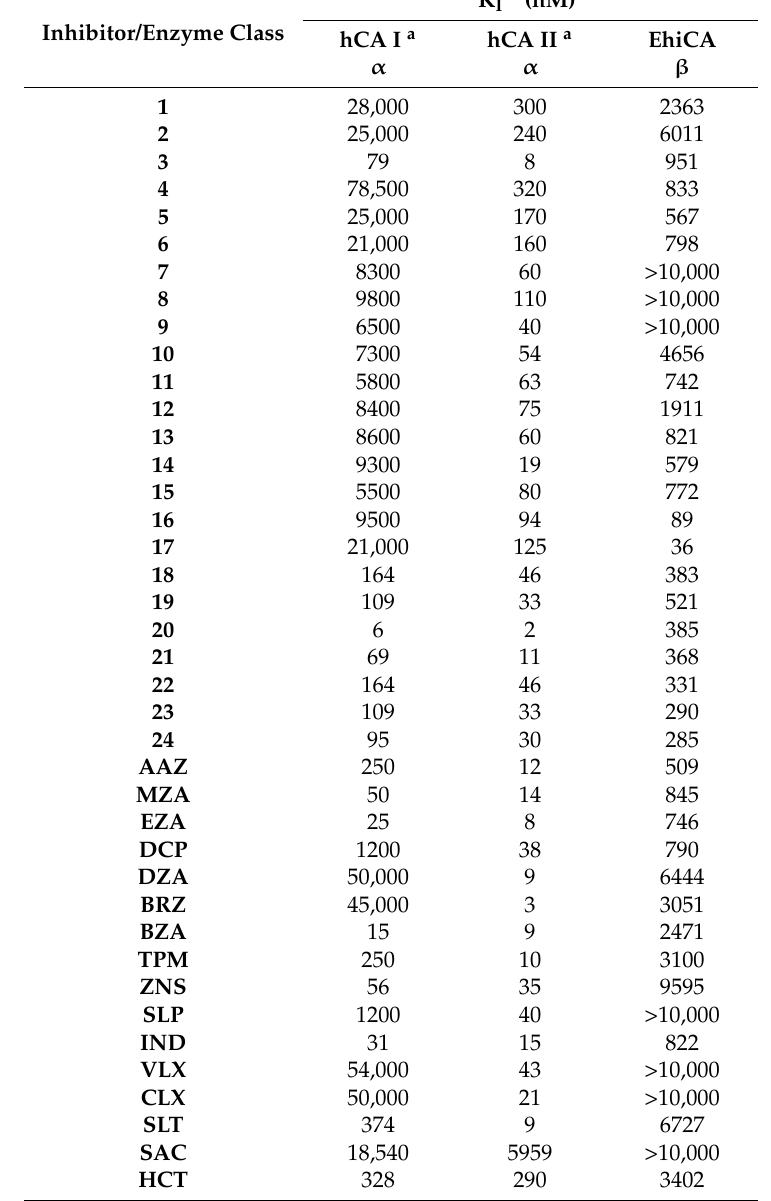
Table 2. Inhibition of the human isoforms hCA I and hCA II, and Entamoeba histolytica (EhiCA) from Entamoeba histolytica with sulfonamides 1 – 24 and the clinically used drugs AAZ–HCT , by a stopped-flow, CO 2 hydrase assay